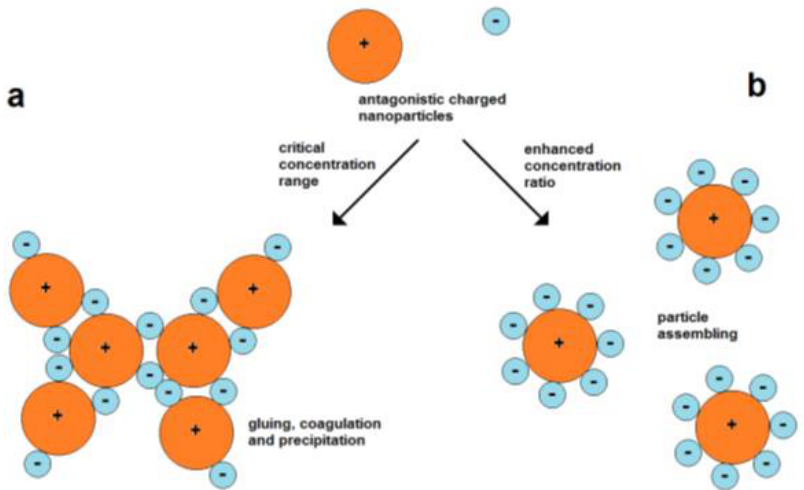
Figure 6. Coagulation and assembly of oppositely charged nanoparticles; ( a ) high probability of coagulation at lower concentration ratios, ( b ) forming of dispersed assemblies at higher concentration ratios between small negative and larger positive particles